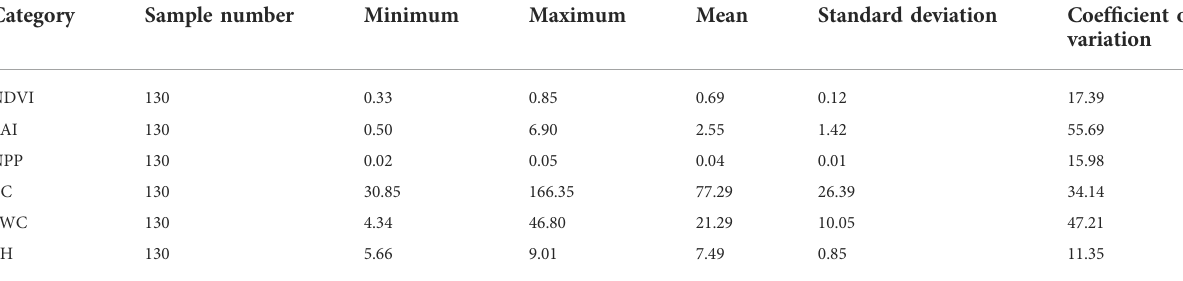
TABLE 3 Statistical characteristics of vegetation indices and soil properties.